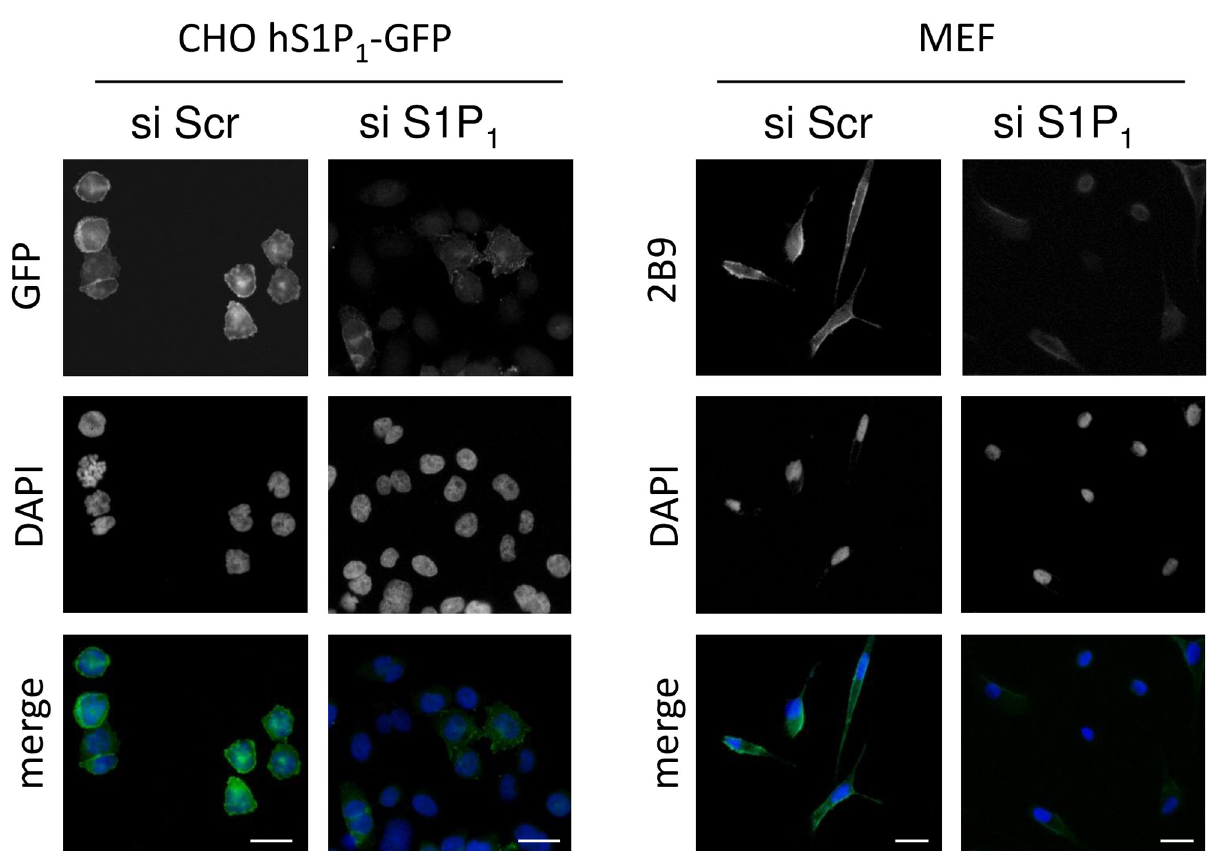
Fig 8. S1P 1 knockdown leads to loss of 2B9 staining. CHO cells stably expressing hS1P 1 -GFP (CHO hS1PR1-GFP) and MEF were transfected with siRNA against S1P 1 (si S1P 1 ) or scramble (si Scr). At 48 hours post transfection, CHO cells were fixed and stained for DNA with DAPI (blue). MEFs were fixed and stained for S1P 1 with 2B9 (1:100, w/v, green) and DNA with DAPI (blue). Images are representative of the population examined. Scale bar, 20 μ